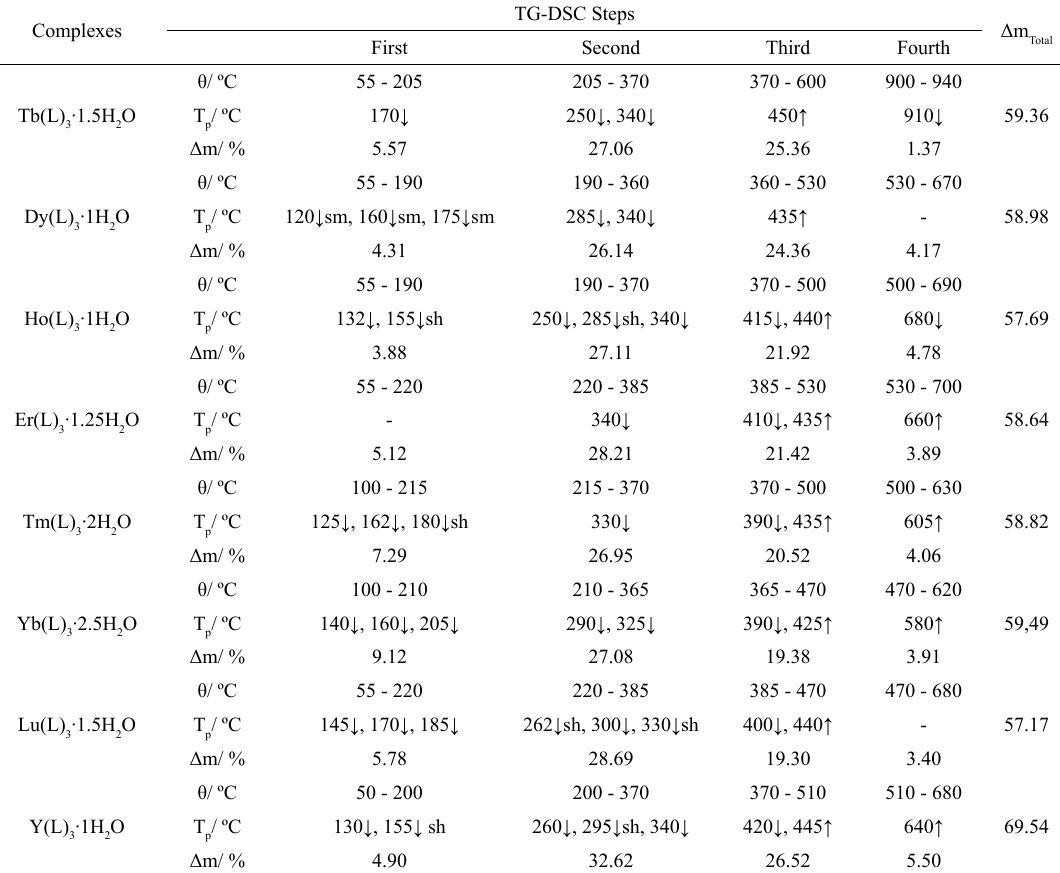
Table 2. Temperature ranges (θ), mass losses (Δm) and peak temperatures (Tp) observed for each step of TG-DSC curves of the complexes.